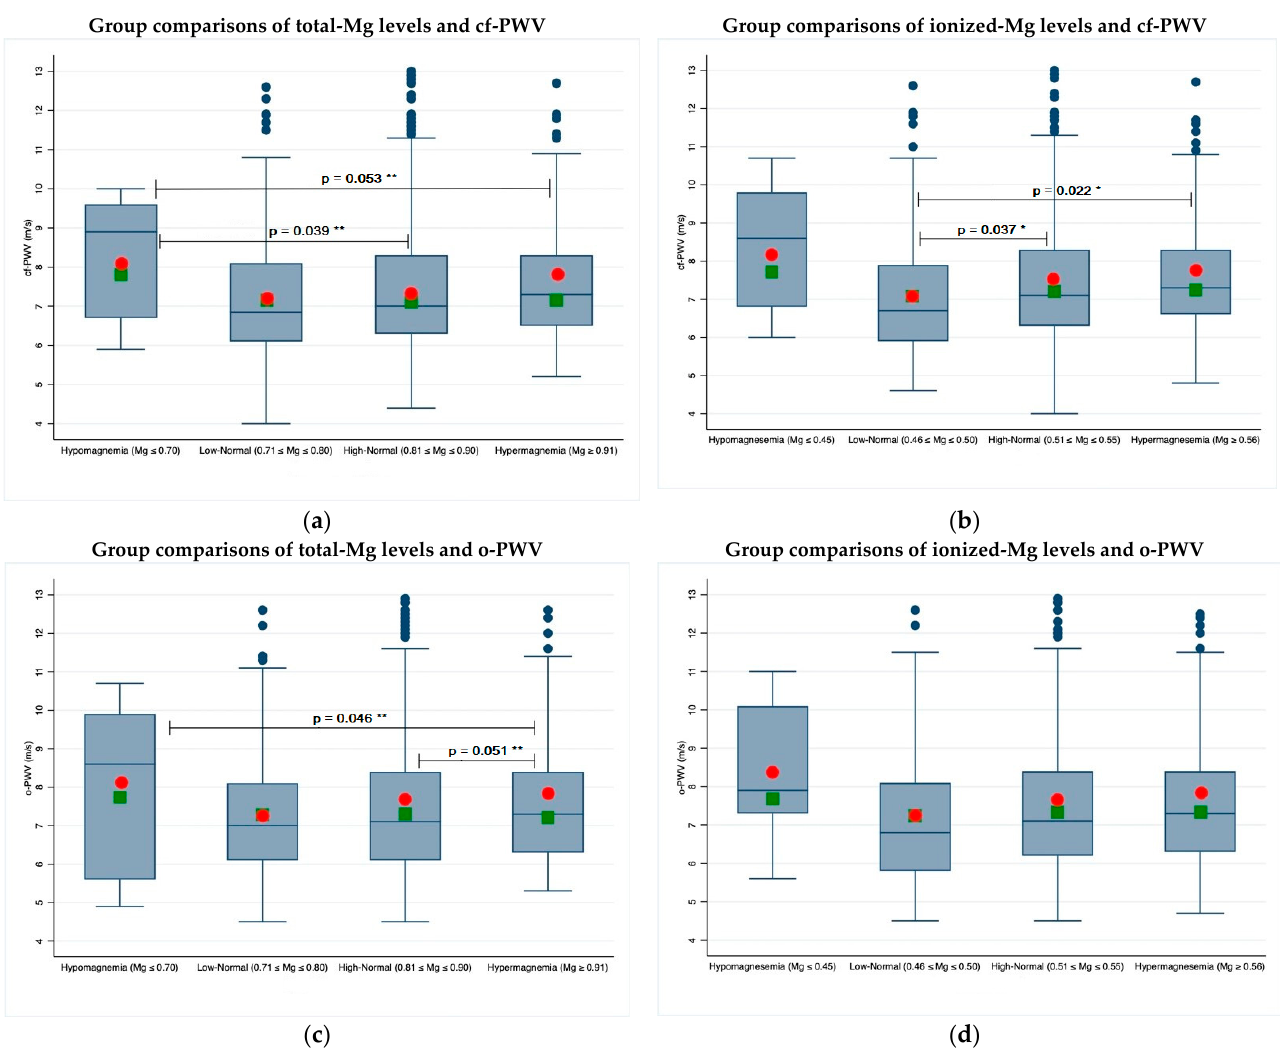
Figure 2. Two-by-two group comparisons of total and ionized magnesium levels and PWV: ( a ) cf-PWV and tot-Mg; ( b ) cf-PWV and ion-Mg; ( c ) o-PWV and tot-Mg; ( d ) o-PWV and ion-Mg. In the box plots, red circles and green squares indicate unadjusted and age-adjusted mean values, respectively, while the blue lines indicate the median values. Significant p -values between unadjusted (*) and adjusted (**) mean values are superimposed on the graphs.